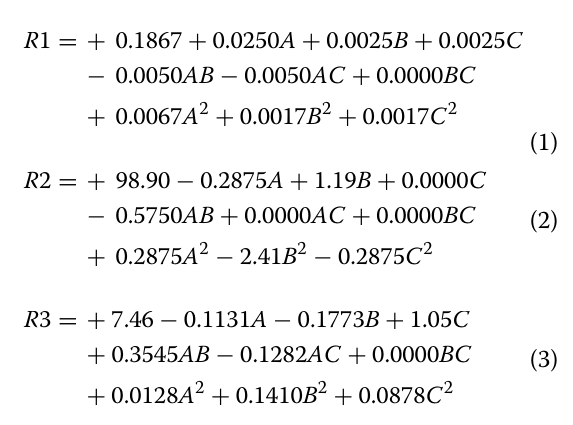
1: Low level (2 mg), 0: Intermediate (6 mg), −